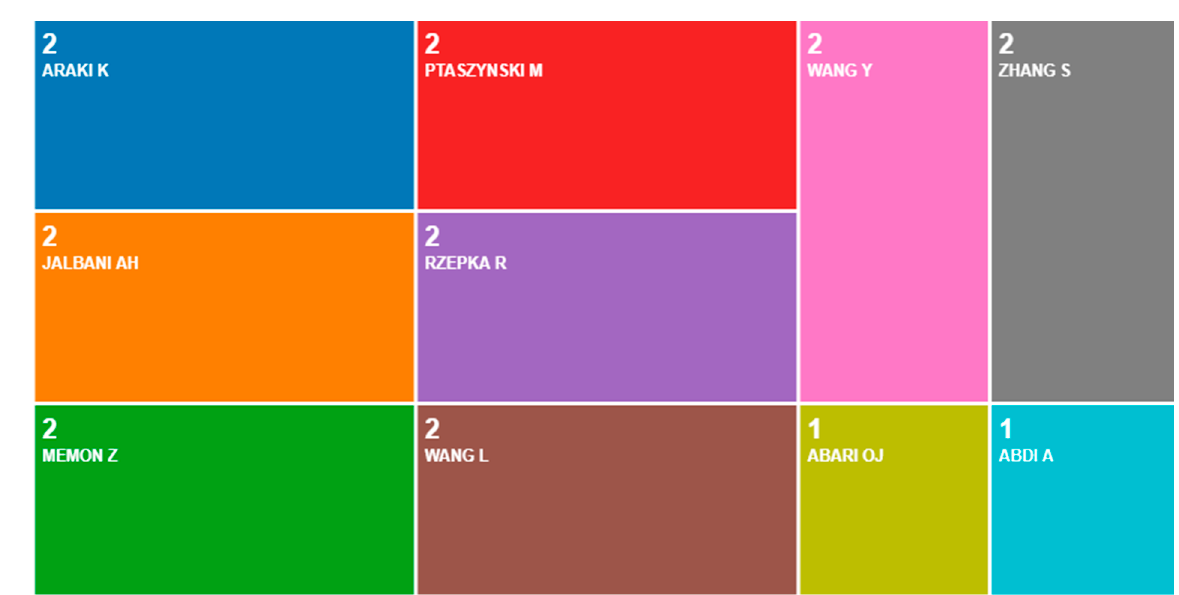
Figure 12. Top Productive Authors on Web of Science.